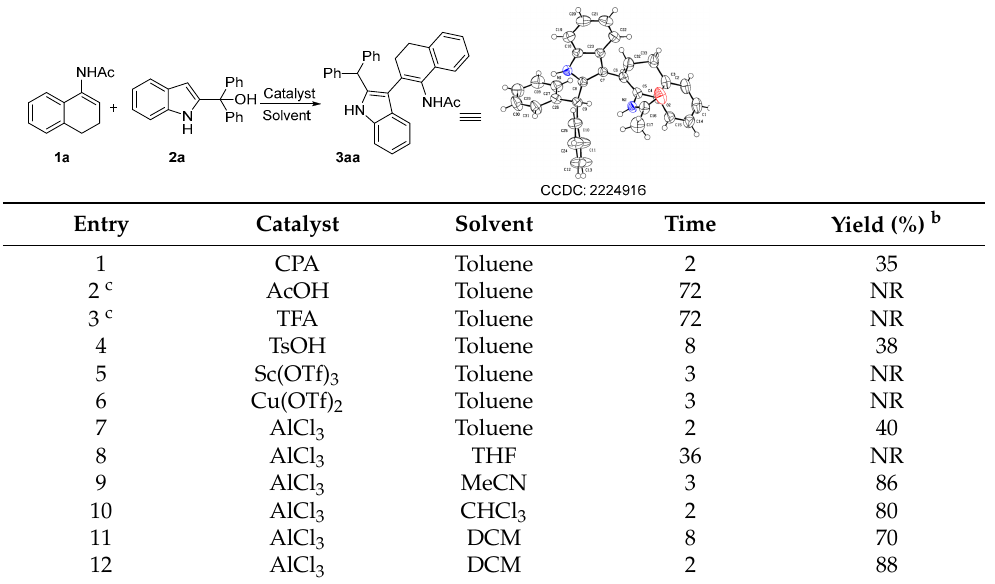
Table 1. Optimization of the reaction conditions a .